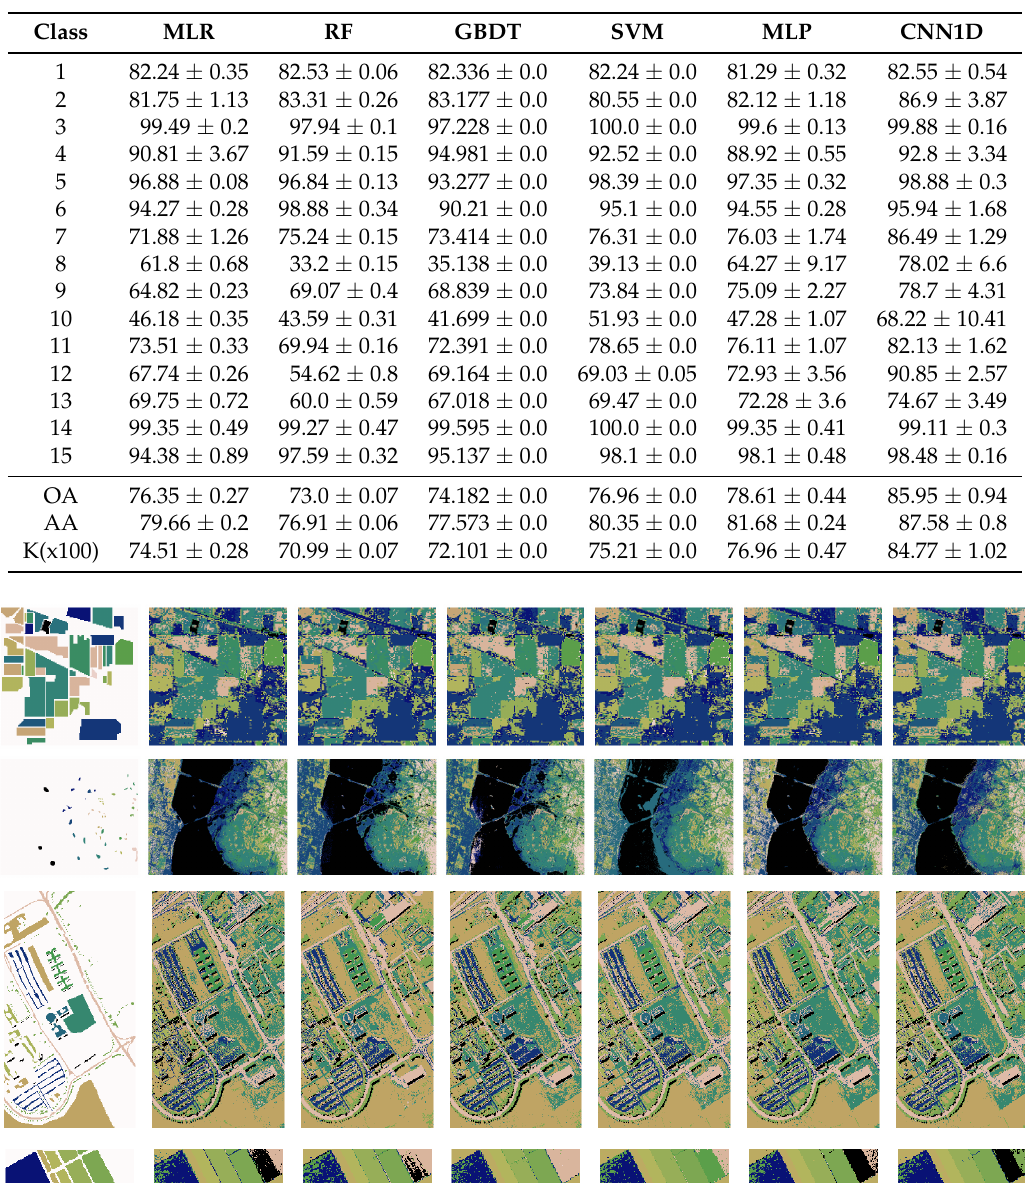
Table 9. UH data set results.